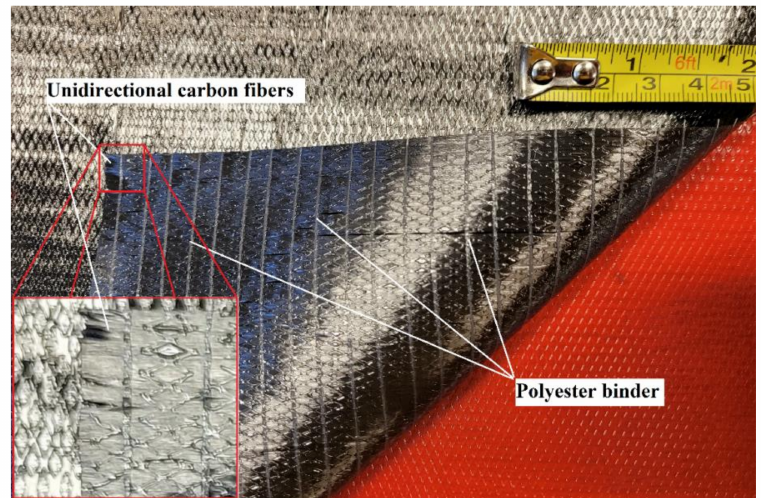
Figure 1. Non-crimp unidirectional carbon